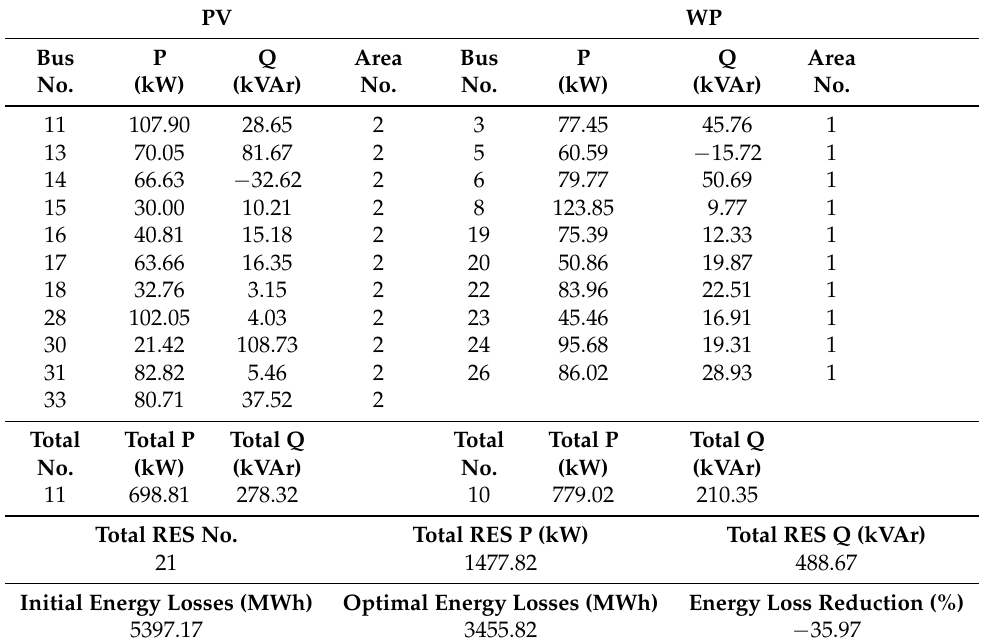
Table 19. Snapshot Approach—mean value—Scenario #2.